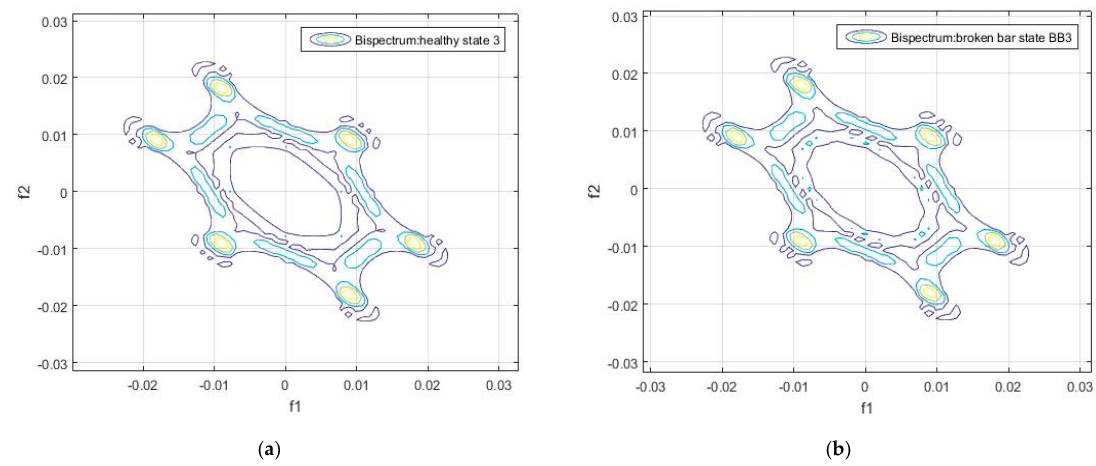
Figure 4. Contour of the bispectrum of the motor flux signal: ( a ) Sample 1 of the healthy motor, ( b ) Sample 1 of the damaged motor, ( c ) Sample 2 of the healthy motor, ( d ) Sample 2 of the damaged motor.